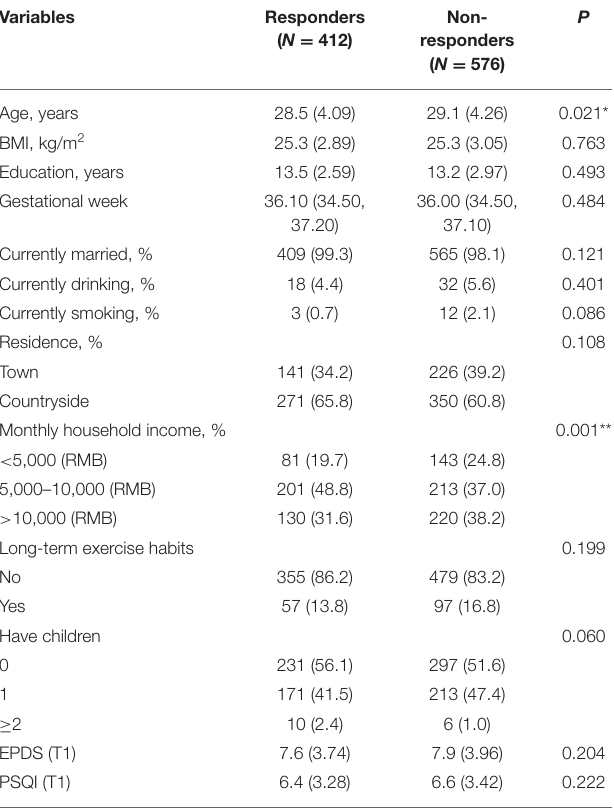
TABLE 1 | Socio-demographics and clinical characteristics between the groups of responders and non-responders.